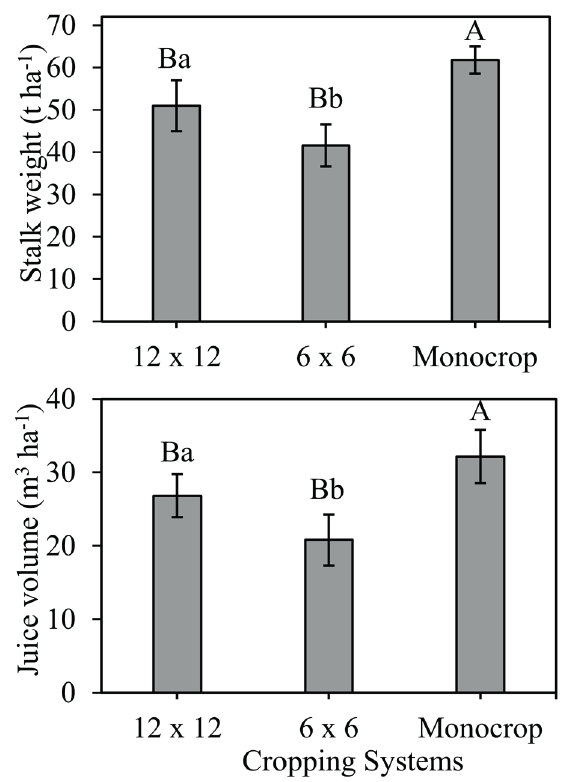
Figure 8 - Stalk weight and juice volume in sugarcane plants in different agroforestry and monocropping systems. Each bar represents the mean value of twelve replications (± s.e.). Means followed by the same letter do not differ among themselves. Uppercase compare the agroforestry systems with the control (Monocropping), by Dunnet test (p> 0.05); and lowercase compare the agroforestry systems (12 x 12 and 6 x 6m), by Tukey test (p>